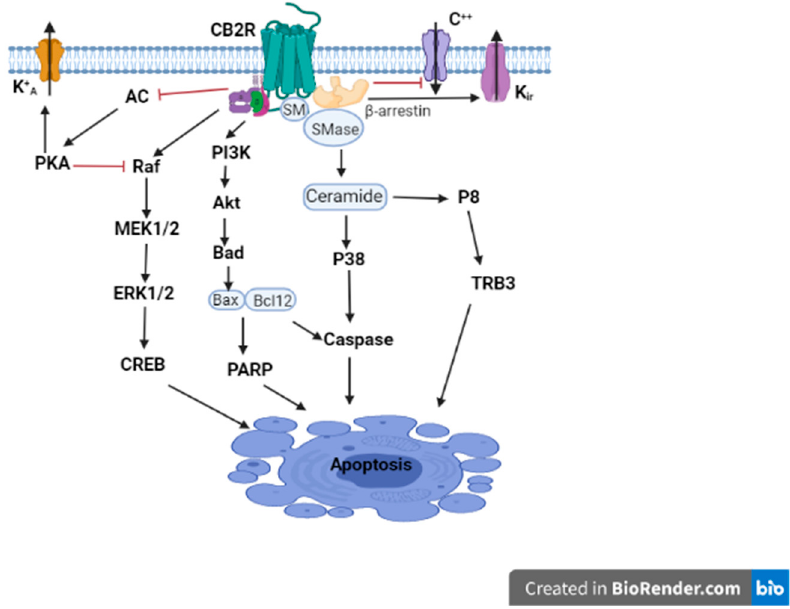
Figure 1. CB2R signaling. CB2R activation is associated with the G βγ -dependent activation of the different MAPK cascades, and the G α i/o-dependent inhibition of AC activity, in turn, results in the inhibition of A-type potassium channels (K + A). CB2R activation also results in the inhibition of specific calcium channels (Ca++), enhances the opening of inwardly rectifying potassium (Kir) channels, and stimulates the de novo synthesis of ceramide and the recruitment of β -arrestin. This figure is only a depiction of one outcome; these pathways can have multiple outcomes—ranging from stimulation of growth, manipulation of metabolism, control of the immune system to cell death—and the outcome is very context- and cell-dependent. The modulation of calcium alone can have multiple